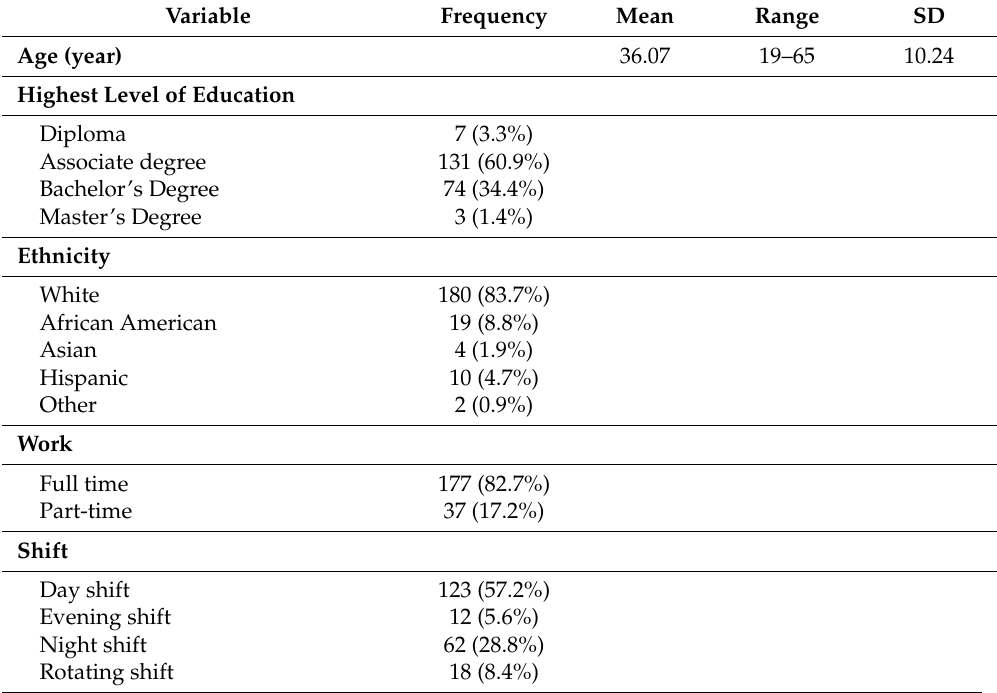
Table 1. Demographic and Health Characteristics of Female Staff Nurses ( n =